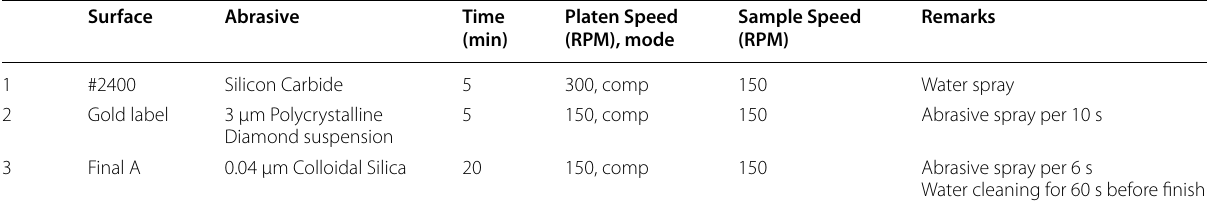
Table 1 Procedures of mechanical polishing for copper foil preparation